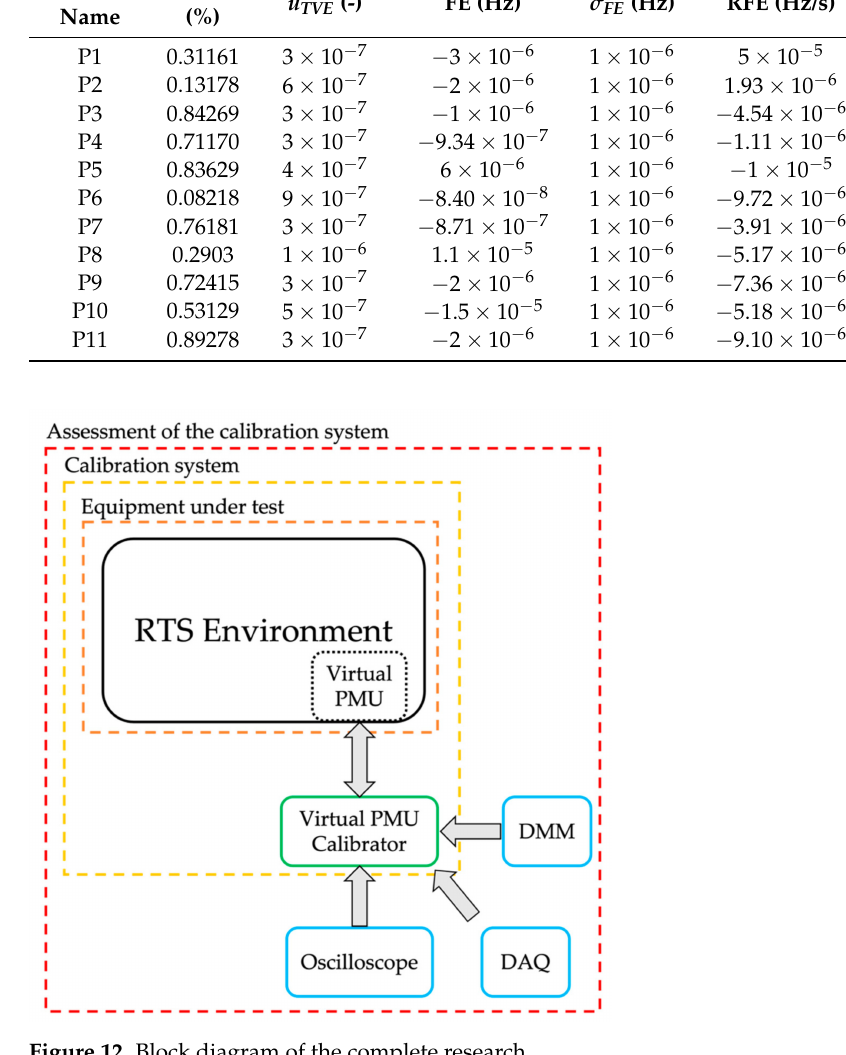
Figure 12. Block diagram of the complete